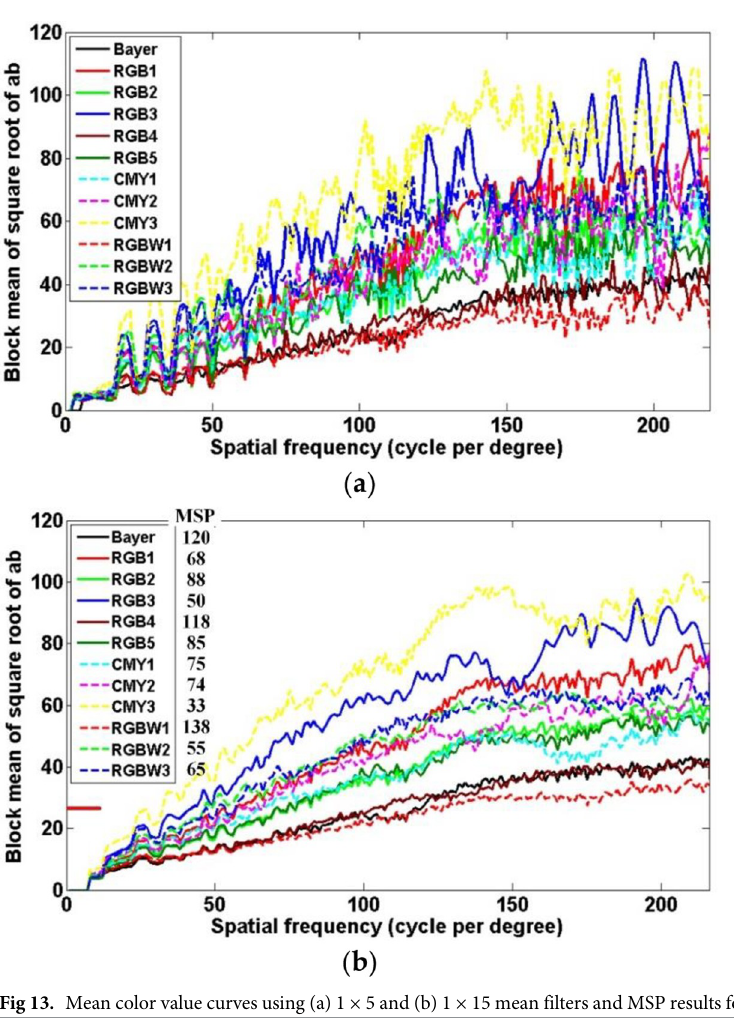
Fig 13. Mean color value curves using (a) 1 × 5 and (b) 1 × 15 mean filters and MSP results for test CFAs.